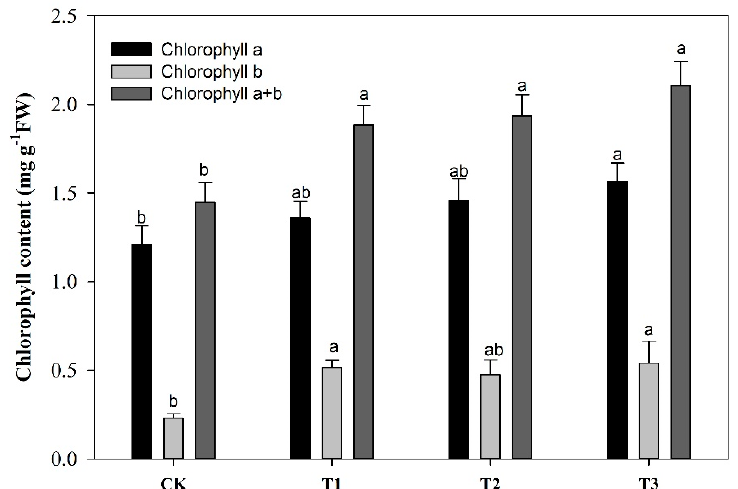
Figure 1. Chlorophyll a (Chl a), chlorophyll b (Chl b) and total chlorophyll contents (Chl a + b) in the leaves of cucumber under different concentrations of garlic substrate. Values represent the mean SE ( n = 3). Different letters indicate a significant difference between treatments at p < 0.05, according to the LSD test.